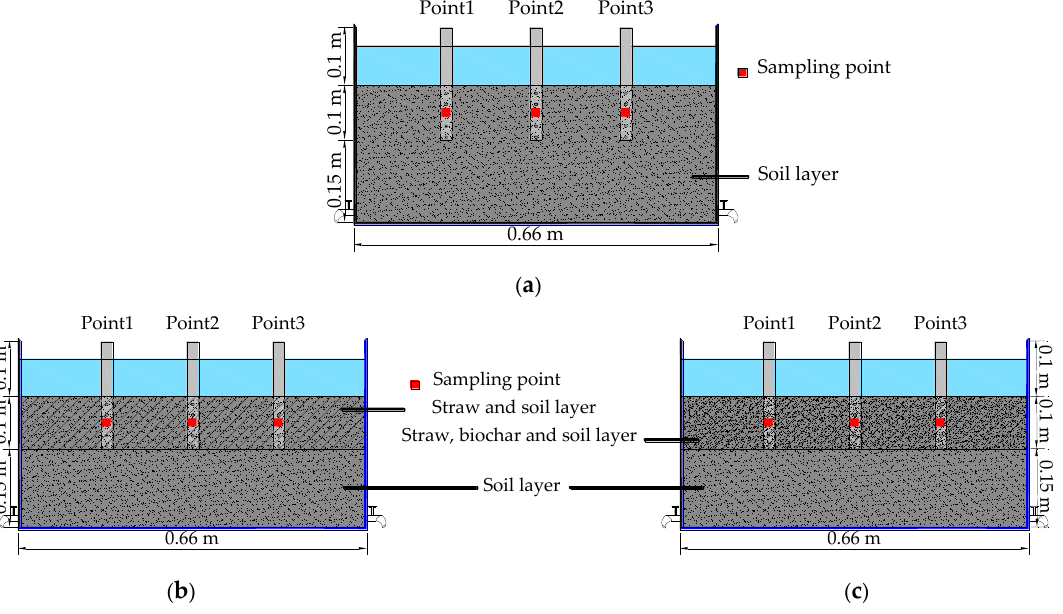
Figure 1. A schematic diagram for the experiment treatments: ( a ) No wheat straw returning (CK); ( b ) Wheat straw returning (ST); and ( c ) Both wheat straw and biochar returning. Point1, point2 and point3 represent the 0–10 cm soil water sampling point, which is repeated three